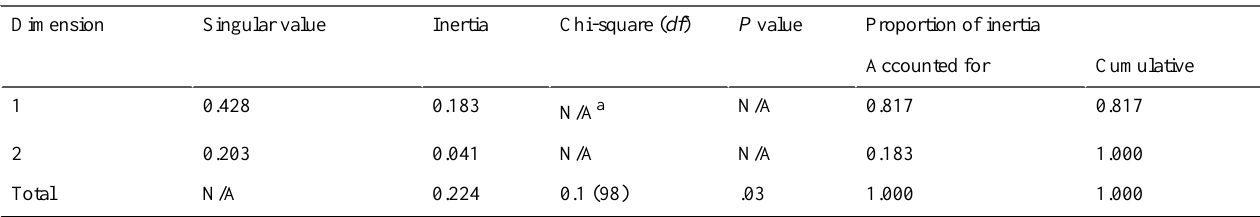
Table 3. Summary table of the correspondence